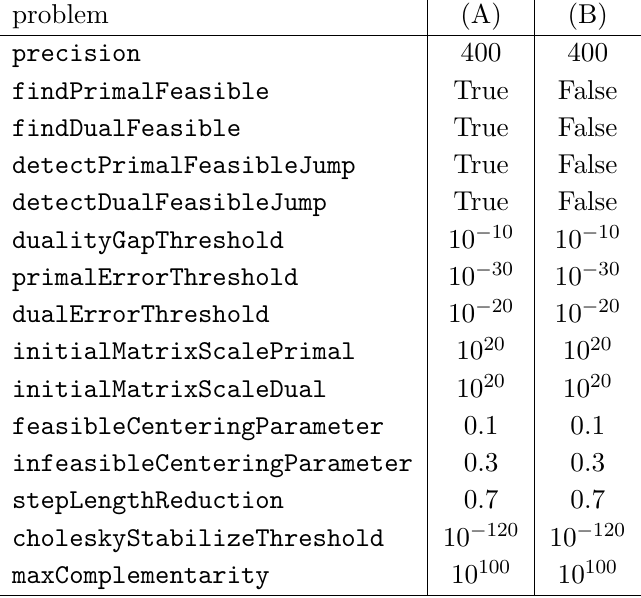
Table 1 . SDPB parameters for bounds on scaling dimensions (A) and OPE coe(cid:14)cients (B). and can be computed from (E.11). We have a second order pole at (cid:26) -order 2 m +2 ‘ +4, a (cid:12)rst order pole at (cid:26) -order 2 ‘ +3+ m and a (cid:12)rst order pole at (cid:26) -order m +1. Since these contribute at di(cid:11)erent (cid:26) -orders, they are cut o(cid:11) at di(cid:11)erent values of m . Therefore, e(cid:11)ectively in our ansatz we will have (cid:12)rst-order poles which come from second-order poles with second-order piece neglected due to its high (cid:26) -order. Similarly, when computing h reg